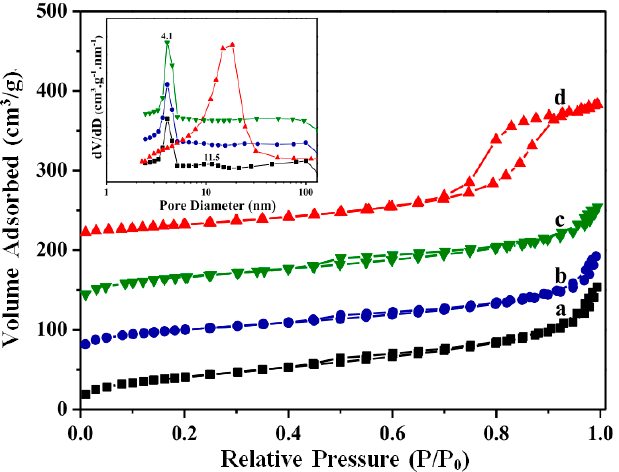
Figure 24. (A) Nitrogen adsorption–desorption isotherms and (B) the size distribution curves of the